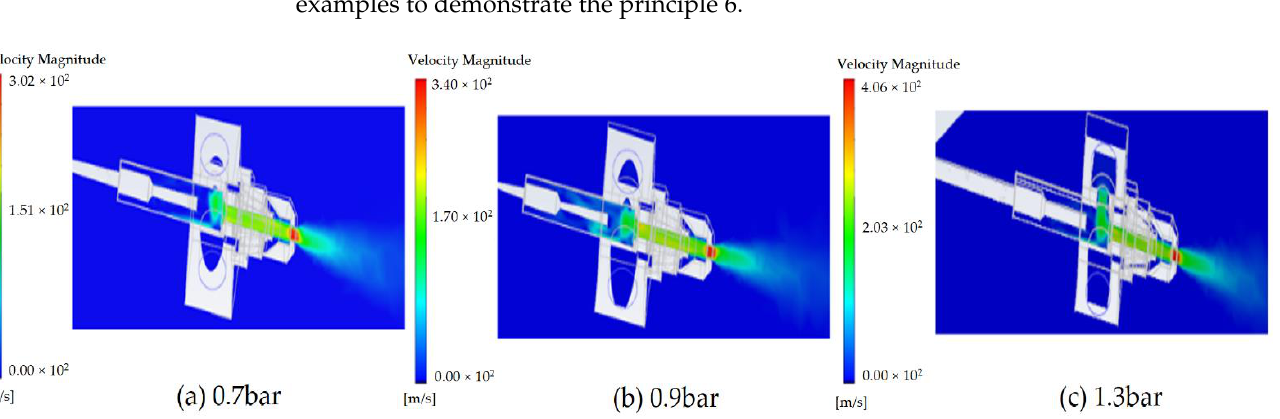
Figure 6. Velocity contours under different compressed air inlet pressure